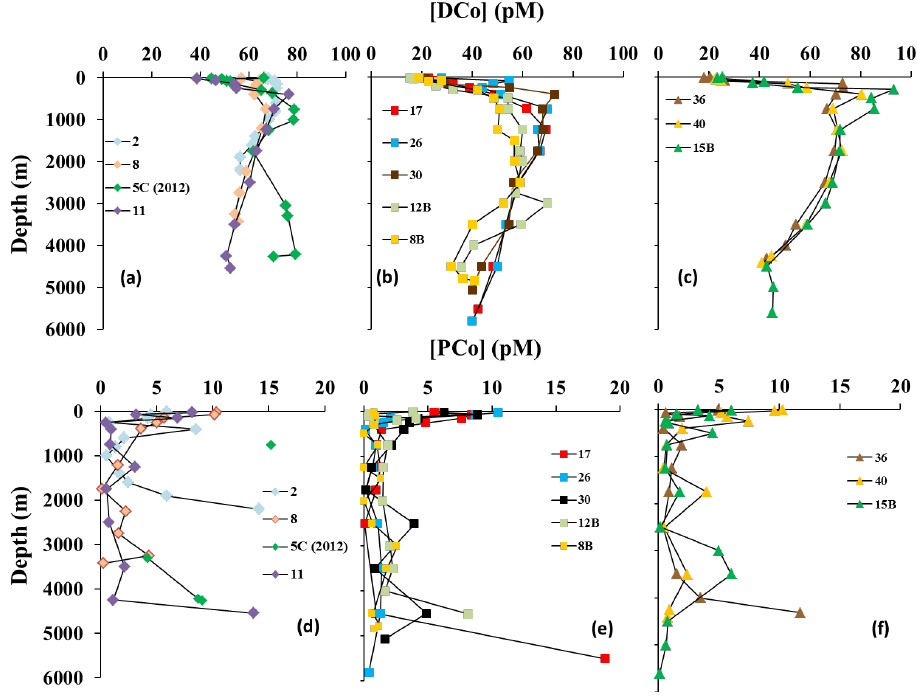
Fig. 5. Typical vertical distribution of dissolved ( D Co) and apparent particulate ( P Co) cobalt against depth in the different biogeochemical domains: in the SAG, D Co (a) and P Co (d) are shown for Station 2 (64 ◦ N, 34.25 ◦ W), St. 8 (54 ◦ N, 45.84 ◦ W) St. 5c (50 ◦ N, 44 ◦ W) and St. 11 (48 ◦ N, 39.4 ◦ W); in the north and south subtropical domains D Co (b) and P Co (e) are shown at St. 17 (34.3 ◦ N, 55.4 ◦ W), St. 26 (23 ◦ N, 65.55 ◦ W), St. 30 (18.5 ◦ N, 57.6 ◦ W), St. 12b (22.47 ◦ S, 32.7 ◦ W) and St. 8b (35 ◦ S, 39.4 ◦ W); and in the equatorial area D Co (c) and P Co (f) are presented at St. 36 (7.8 ◦ N, 48.9 ◦ W), St. 40 (1 ◦ N, 39.7 ◦ W) and St. 15b (9 ◦ S, 28 ◦